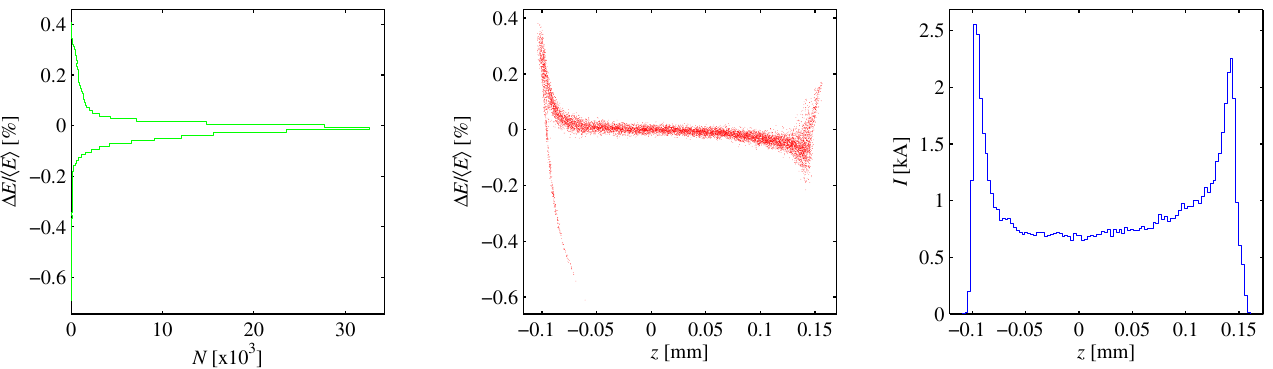
FIG. 13. (Color) Energy profile (left), longitudinal phase space (middle), and bunch current distribution (right) at the linac end when the combined option, passive and active linearizer, is considered. Bunch mean energy h E i ¼ 1076 MeV .